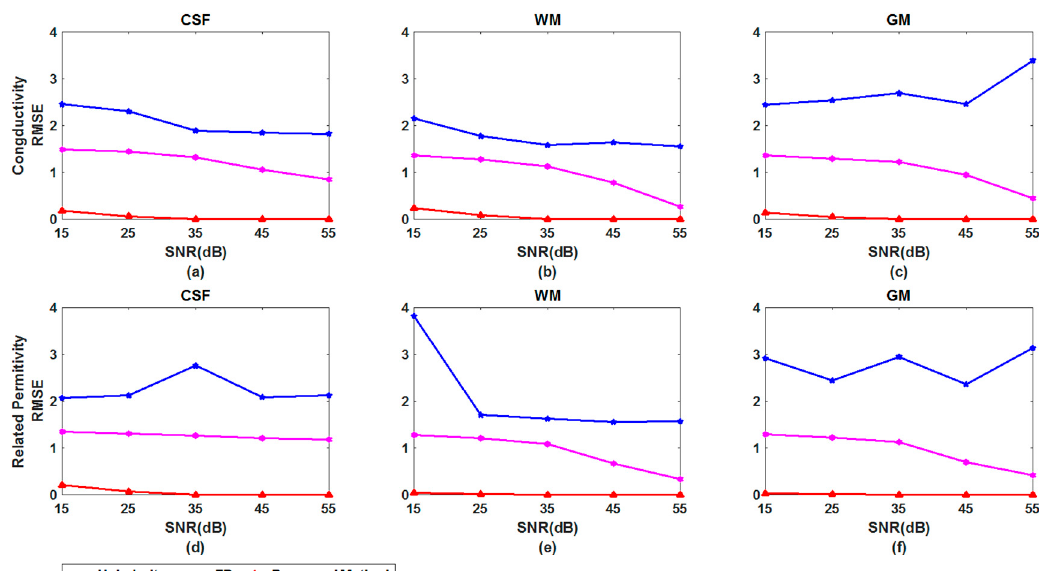
Figure 5. The root-mean-square-errors (RMSE) concerning the reconstructed ε r and σ by using the traditional LHA-based method (blue line), the recently proposed modified Finite-Difference (mFD) method (purple line) and the proposed method (red line) under different SNR levels (from 55 dB to 15 dB). ( a ) and ( d ) retrieve EP’s values in the cerebrospinal fluid (CSF) CSF region, ( b ) and ( e ) retrieve EP’s values in the white matter’s region, ( c ) and ( f ) the retrieved EP’s values in the gray matter’s region.